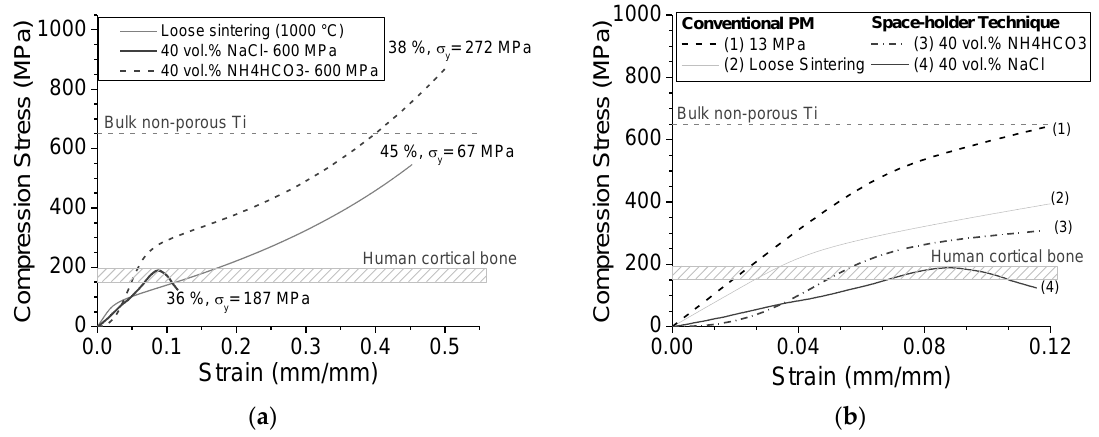
Figure 5. Uniaxial compression tests: ( a ) Young’s modulus closed to the cortical bone is set in ~29 GPa (porosity total range between 37.6 – 44.8%); ( b ) yield strength values are fixed in a range (150 – 200 MPa) meeting the requirements of the cortical tissue. Compression stress vs. Strain curves of specimens manufactured by different PM routes.